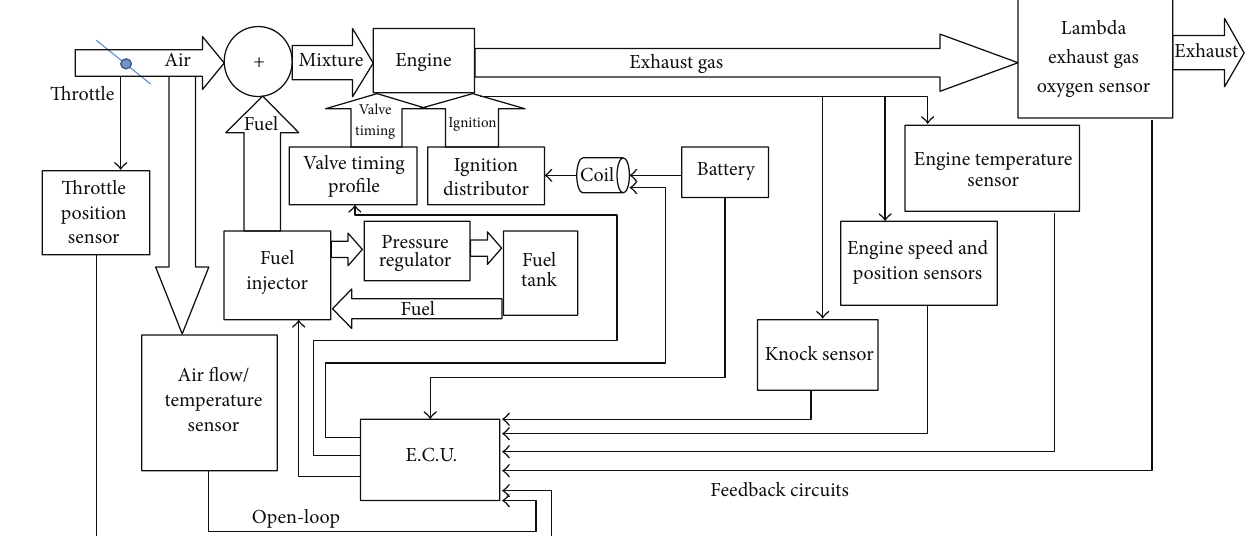
Figure 1: Block diagram of engine control